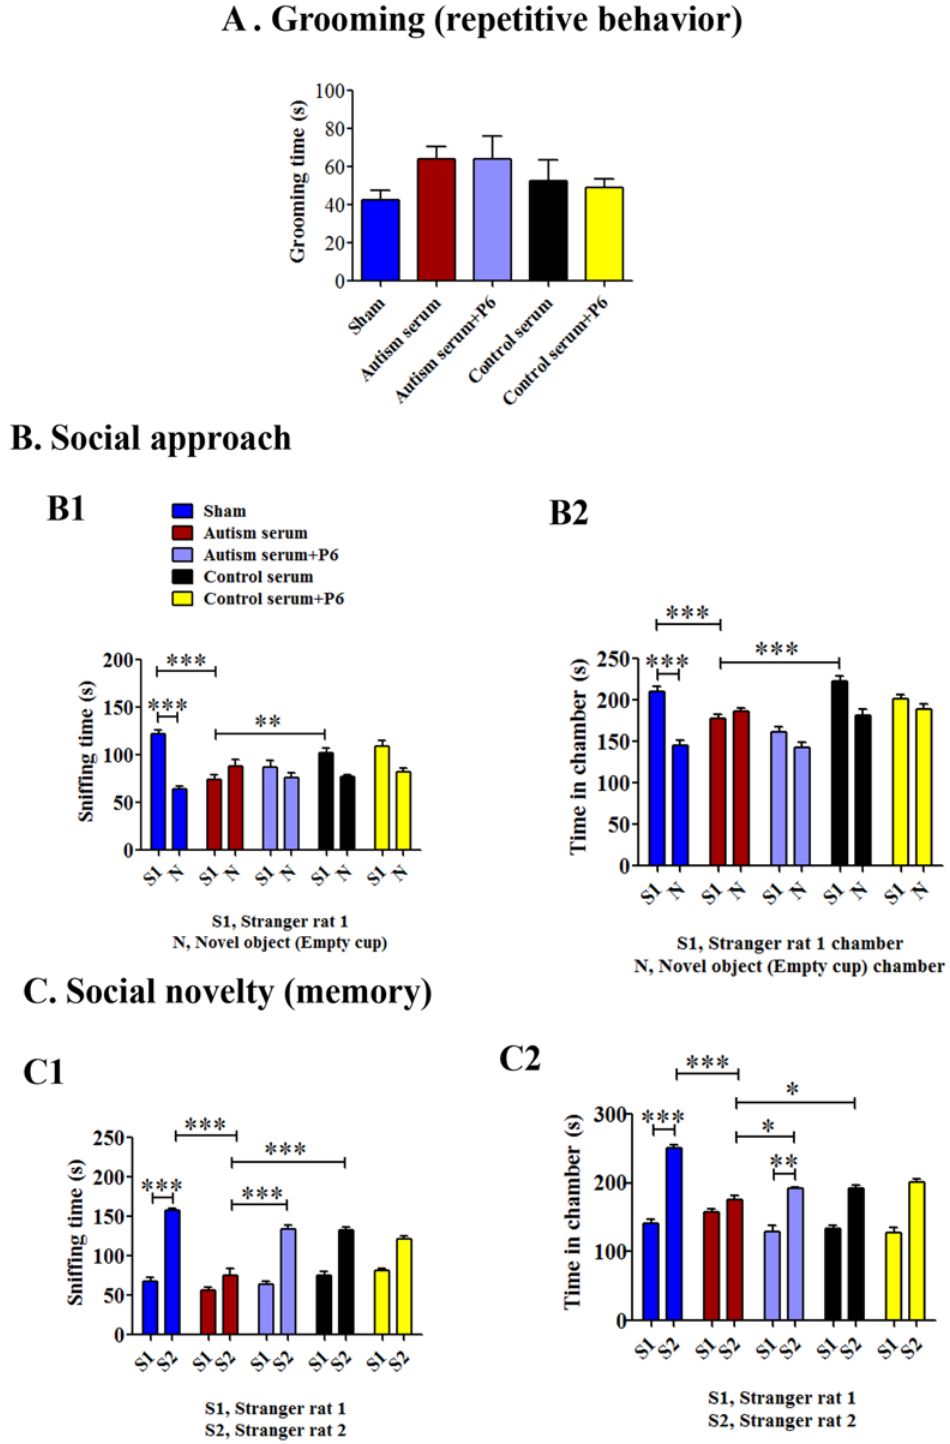
Fig 5. Effect of autism and control sera in the presence or absence of P6 on grooming, social approach and novelty in young Wistar rats. P 0.5 rat pups were injected intracerebroventricularly with saline (sham) or 2% autism or control serum with or without 20 nM P6. ( A ) Grooming time measured during the first 5 min habituation phase in the central chamber of the 3-chamber social approach/novelty task. ( B ) Sniffing time and time in the chamber ( “ stranger rat 1 ” versus “ novel object ” ) spent in the social